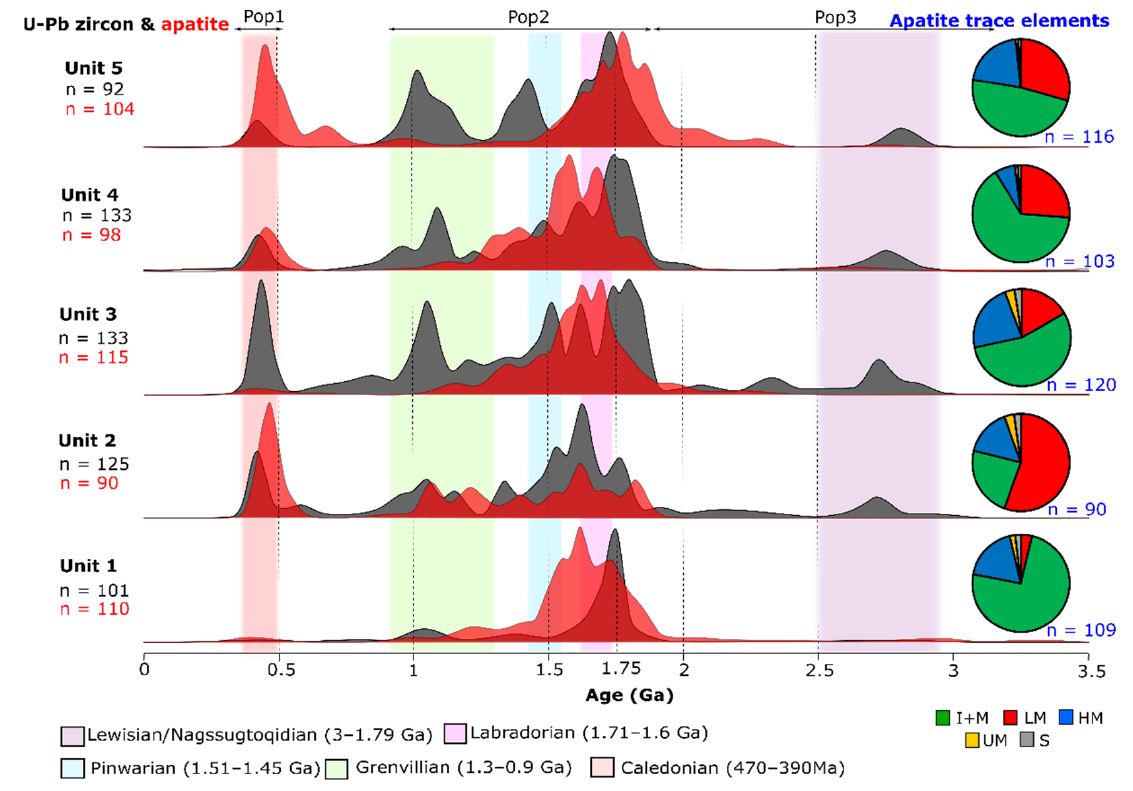
Figure 8. Zircon and apatite U-Pb geochronology results from all channel units in the Mullaghmore Sandstone Formation on Kernel Density Estimates. Bin size is 30 Myr. Major orogenic events are highlighted in the vertical pastel colour bands. Trace elements in apatite visualised on pie charts on far right with key below where I + M: Igneous and mafic; LM: low-grade metamorphic; HM: high-grade metamorphic; UM: ultramafic; S: S-type granitoid.